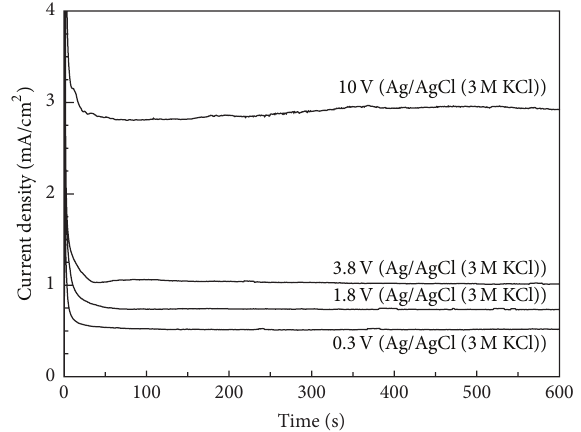
Figure 4: Current density-time behaviour during potentiostatic anodising in 0.4 M sulphuric acid on EN AW-7075 T73 using the micro-capillary technique to form circular oxide areas 800 𝜇 m in diameter.